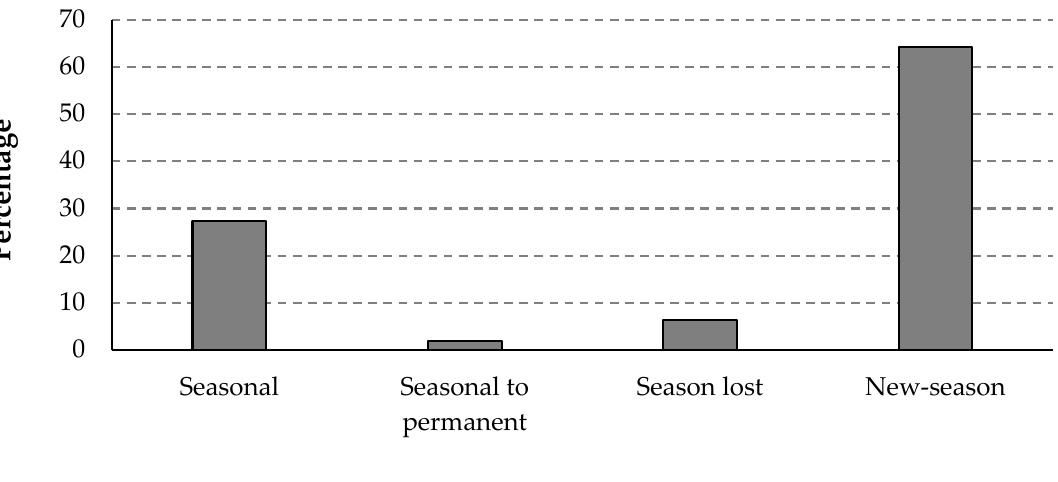
Figure 5. Percentage of seasonal water resources in Iran (1990–2021).